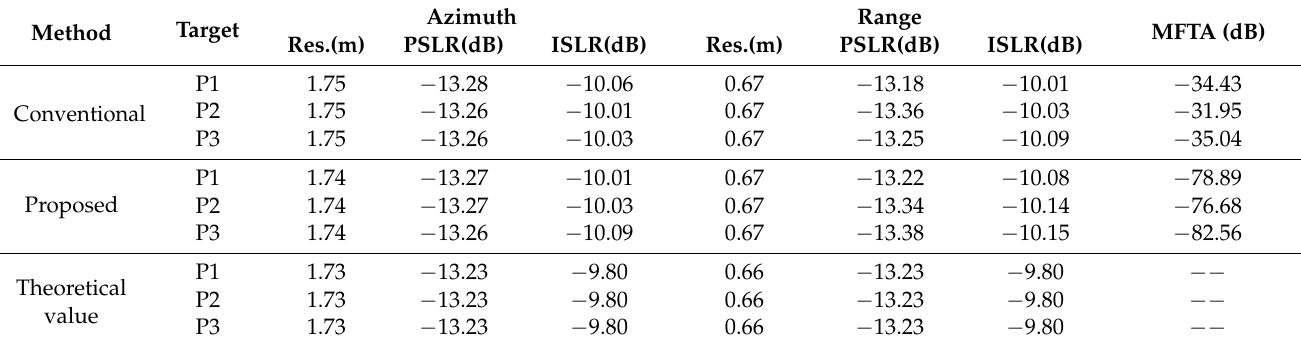
Figure 15. Imaging results of the designed scene with nine point targets handled by the conventional approach based on CHRE. ( a ) The designed scene imaging result; ( b ) contour plots of P1; ( c ) contour plots of P2; ( d ) contour plots of P3. Table 2. The measured focusing parameters of simulated point targets in Figures 15 and